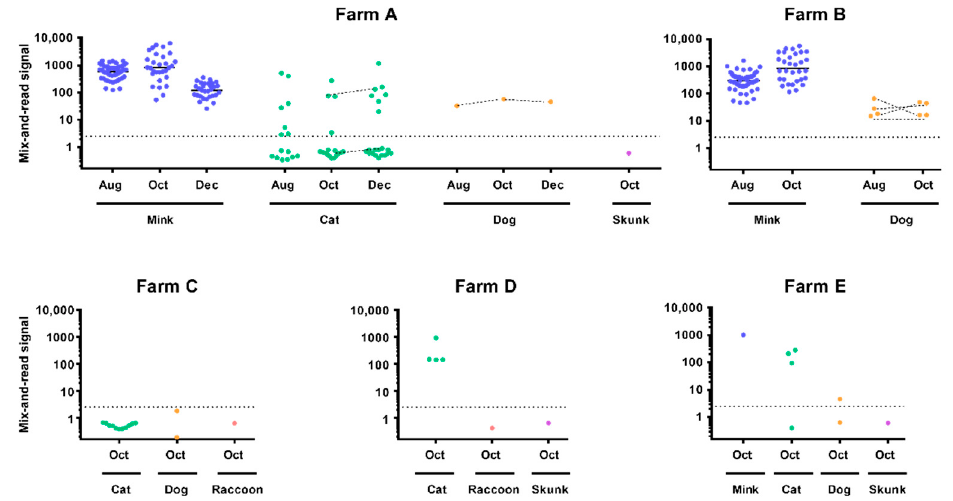
Figure 2. Animal serology. Results of the mix-and-read assay are presented for each tested farm, species, and time-point. The dotted line indicates assay cut-off (2.5; 2.8 used for cats). Connected dots represent re-sampling of the same animal. Mink values are derived from diluted sample specimen results as described in methods. For mink, means of log-transformed values are shown by horizontal lines. Table 2. Summary of longitudinal animal SARS-CoV-2 rRT-PCR and serology results by farm and species .